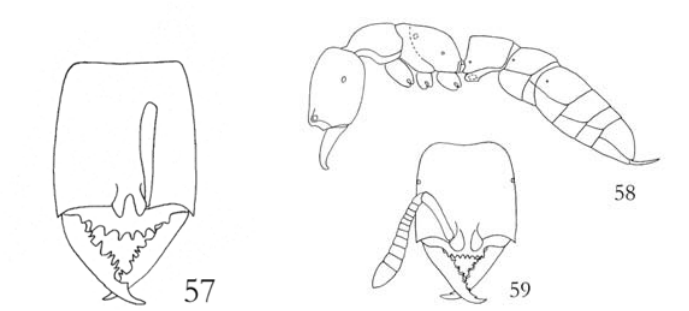
Figs. 57-59. 57: Worker of Amblyopone annae Arnol’di, head in full-face view. (Cited from Arnol’di, 1968, slightly modified). 58-59: Worker of Amblyopone octodentata Xu; 58. Head and body in profile view; 59. Head in full-face view. (Drawn from Antweb